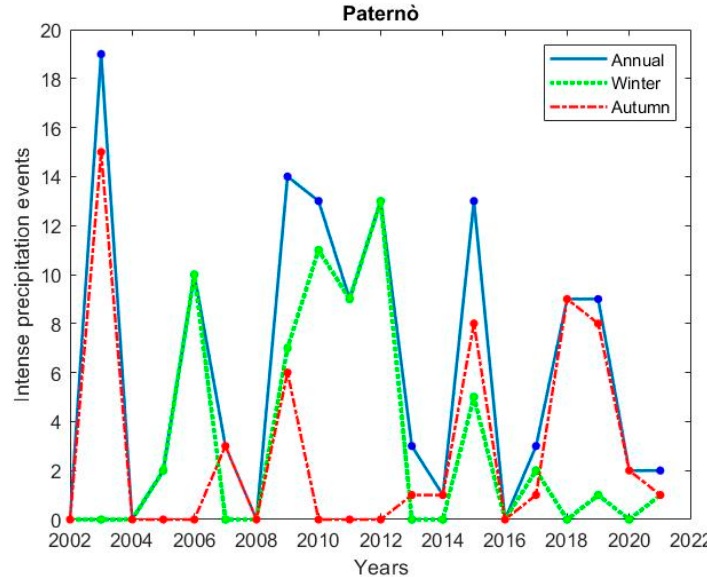
Figure 5. Trends in the number of hours (events) with intense precipitation (greater than 3.6 mm/h), on an annual basis and on a seasonal basis (winter and autumn), for the Paternò case study.